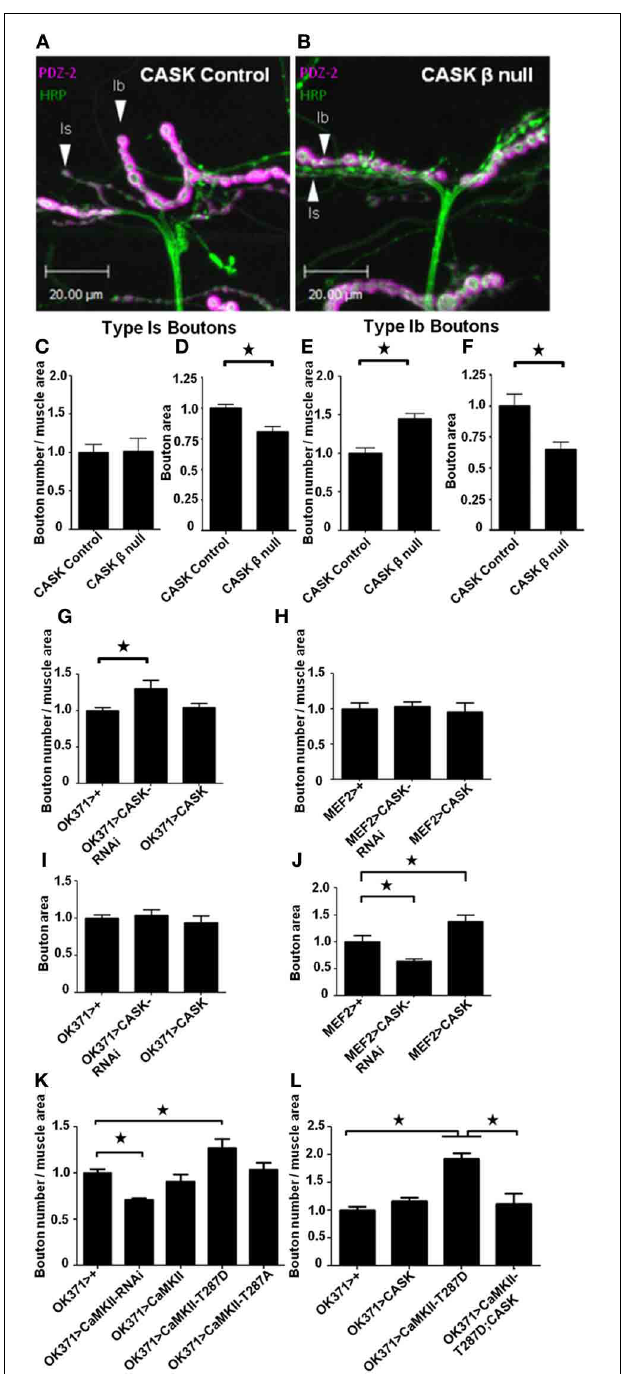
FIGURE 1 | CASK and CaMKII regulate synaptic morphology. Representative images of muscle 12 of Drosophila third-instar larval neuromuscular junctions (NMJ) visualized with the presynaptic marker anti-HRP (green) and the postsynaptic marker anti-DLG (PDZ1-2, magenta). NMJs of larvae with precise (A) and imprecise (B) excisions of CASK ( CASK β null) that remove the CaMK-like and L27 domain-containing version of CASK (Slawson et al., 2011). (C) Compared to controls, the total number of small (type 1s) boutons normalized to muscle area did not change